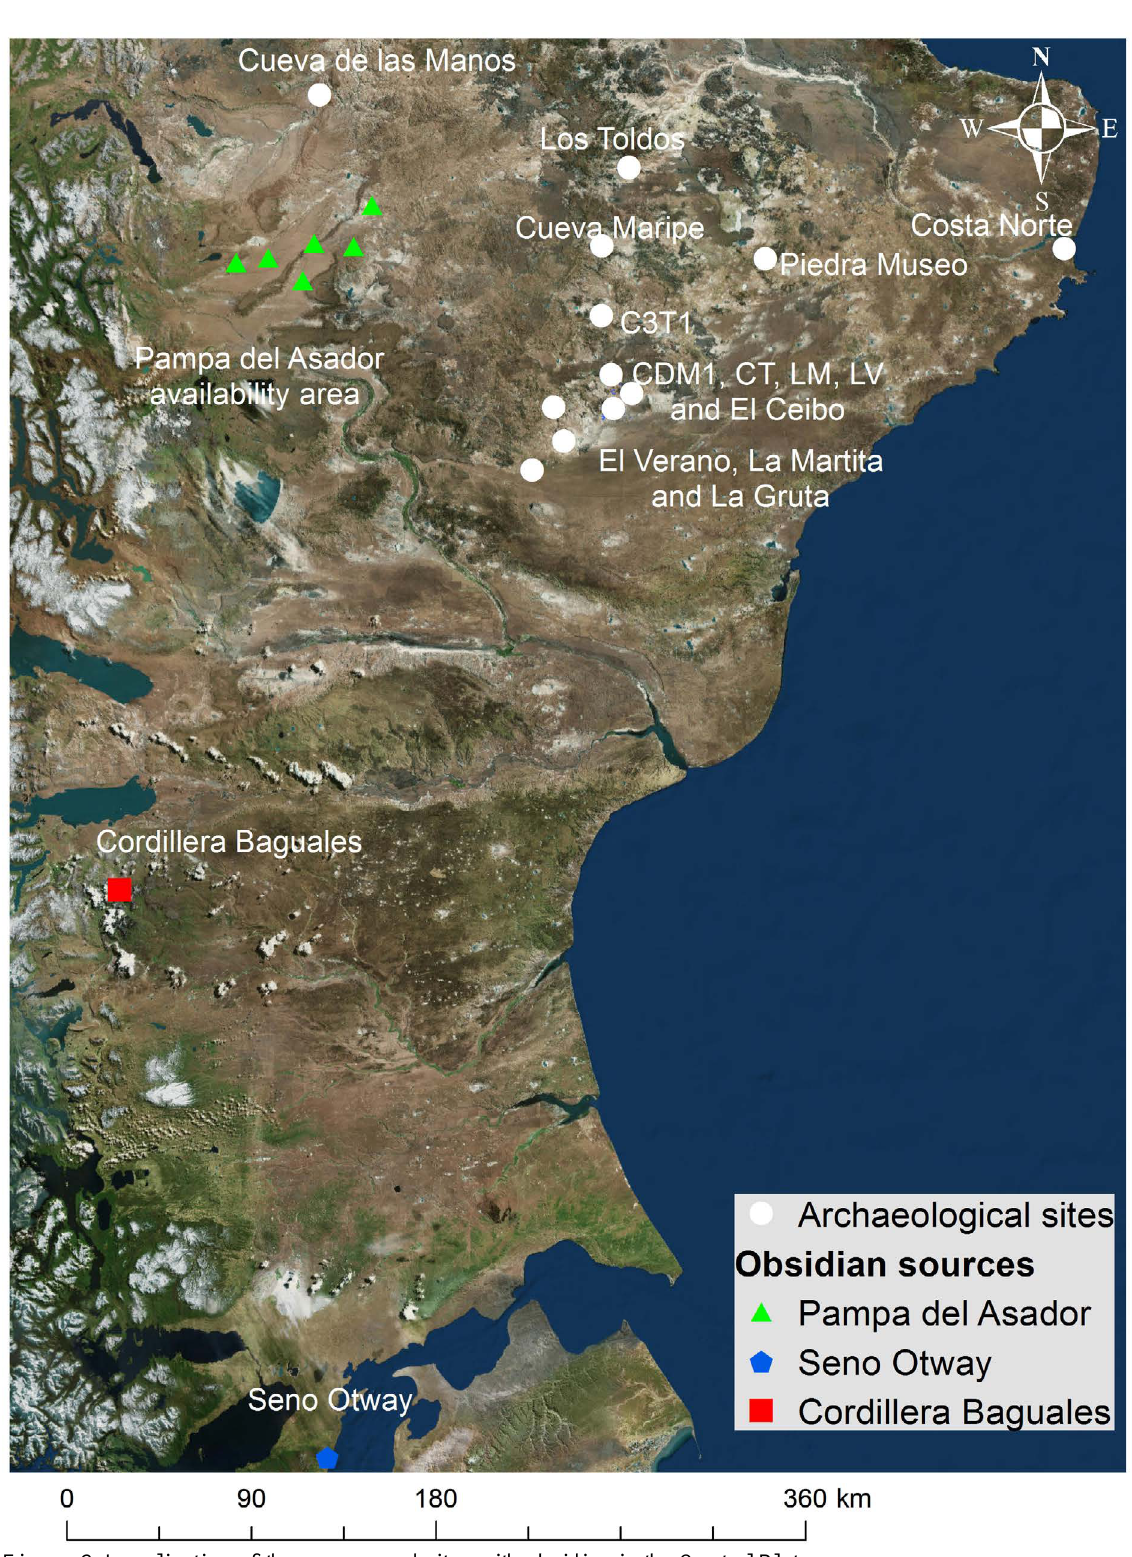
Figure. 2. Localization of the sources and sites with obsidian in the Central